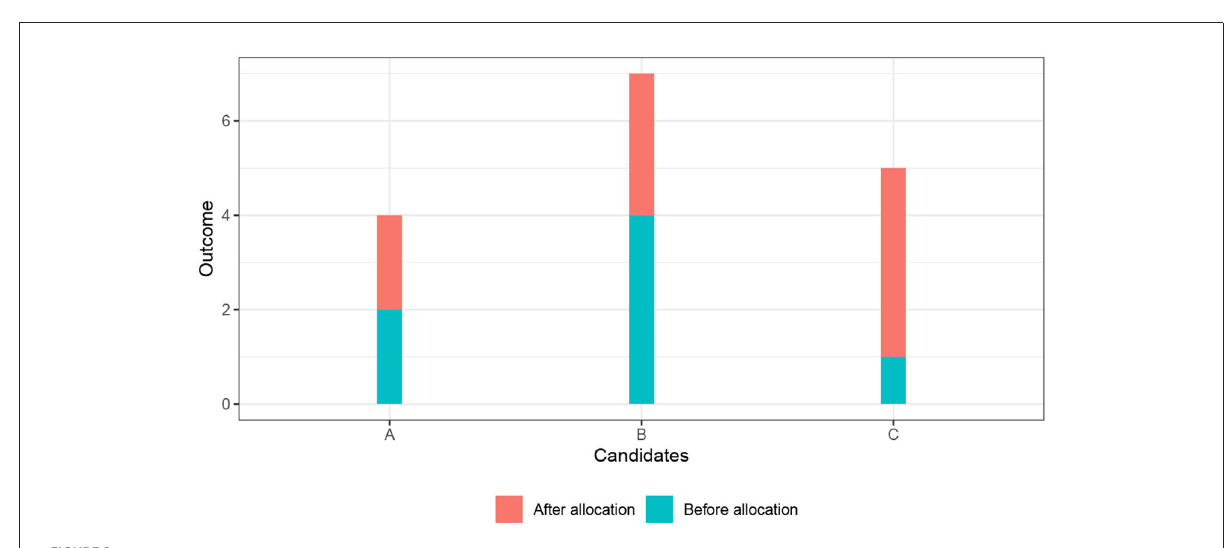
FIGURE2 Illustration of equal outcomes